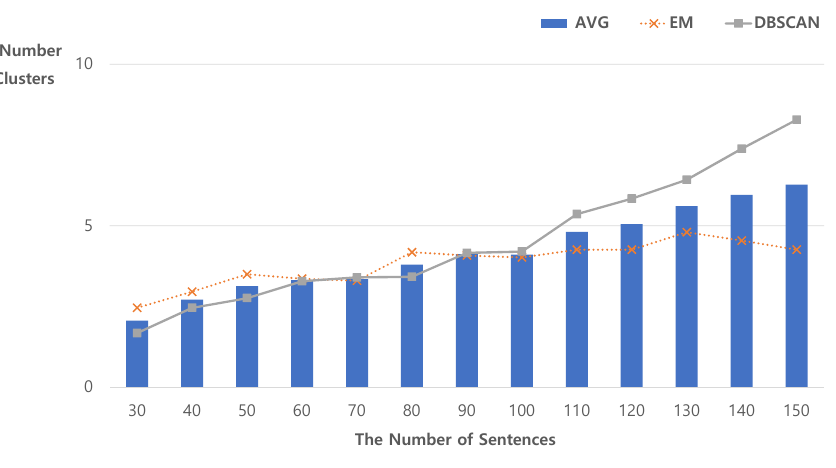
Figure 4. The average number of clusters after 10 runs using the EM and DBSCAN algorithms.